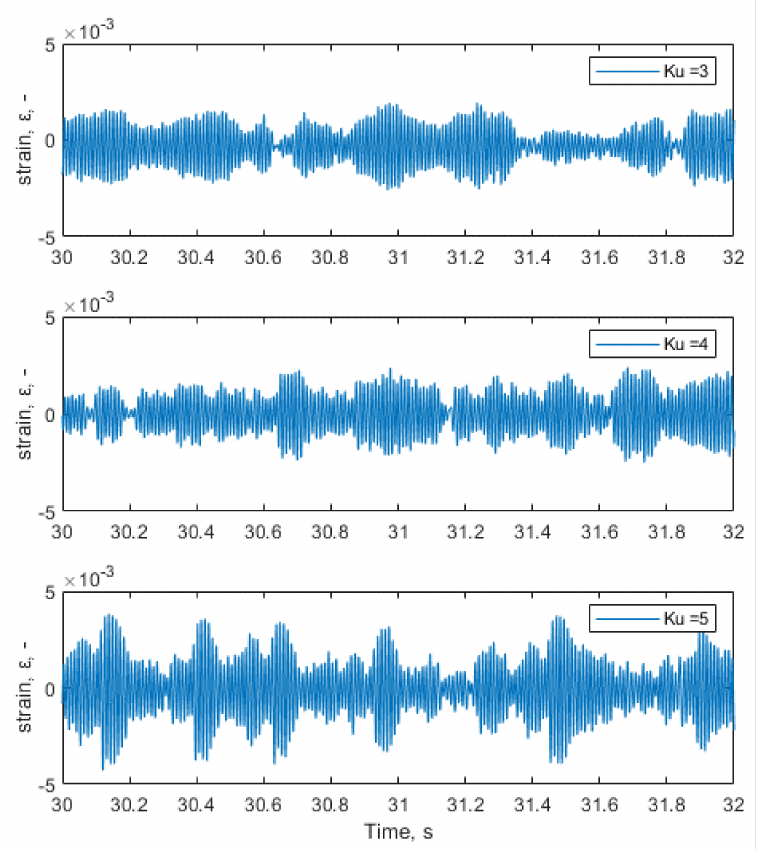
Figure 10. Strain time histories in specimens’ neck for different loading signal kurtosis values.